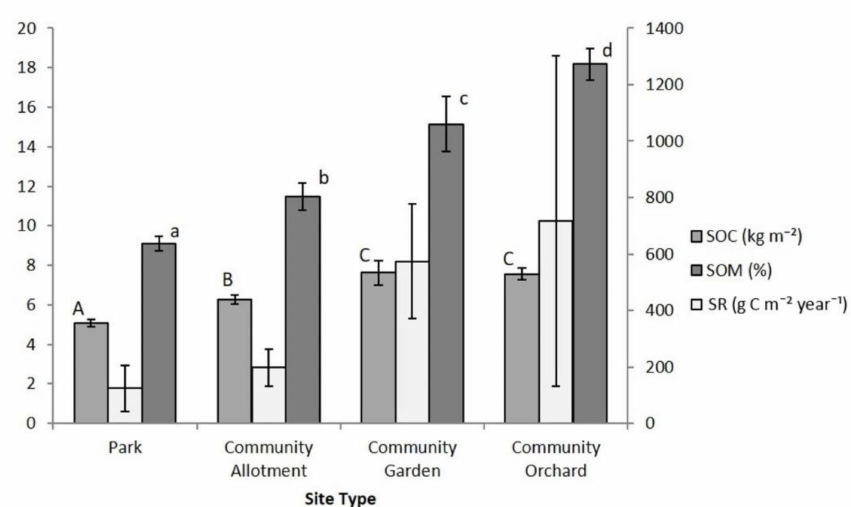
Figure 2. Mean site type SOM percentage by mass and SOC density (primary y axis.), and soil respiration (SR: secondary y axis). Di ff erent letters denote significant mean di ff erence at p < 0.05. Error bars are ± 1